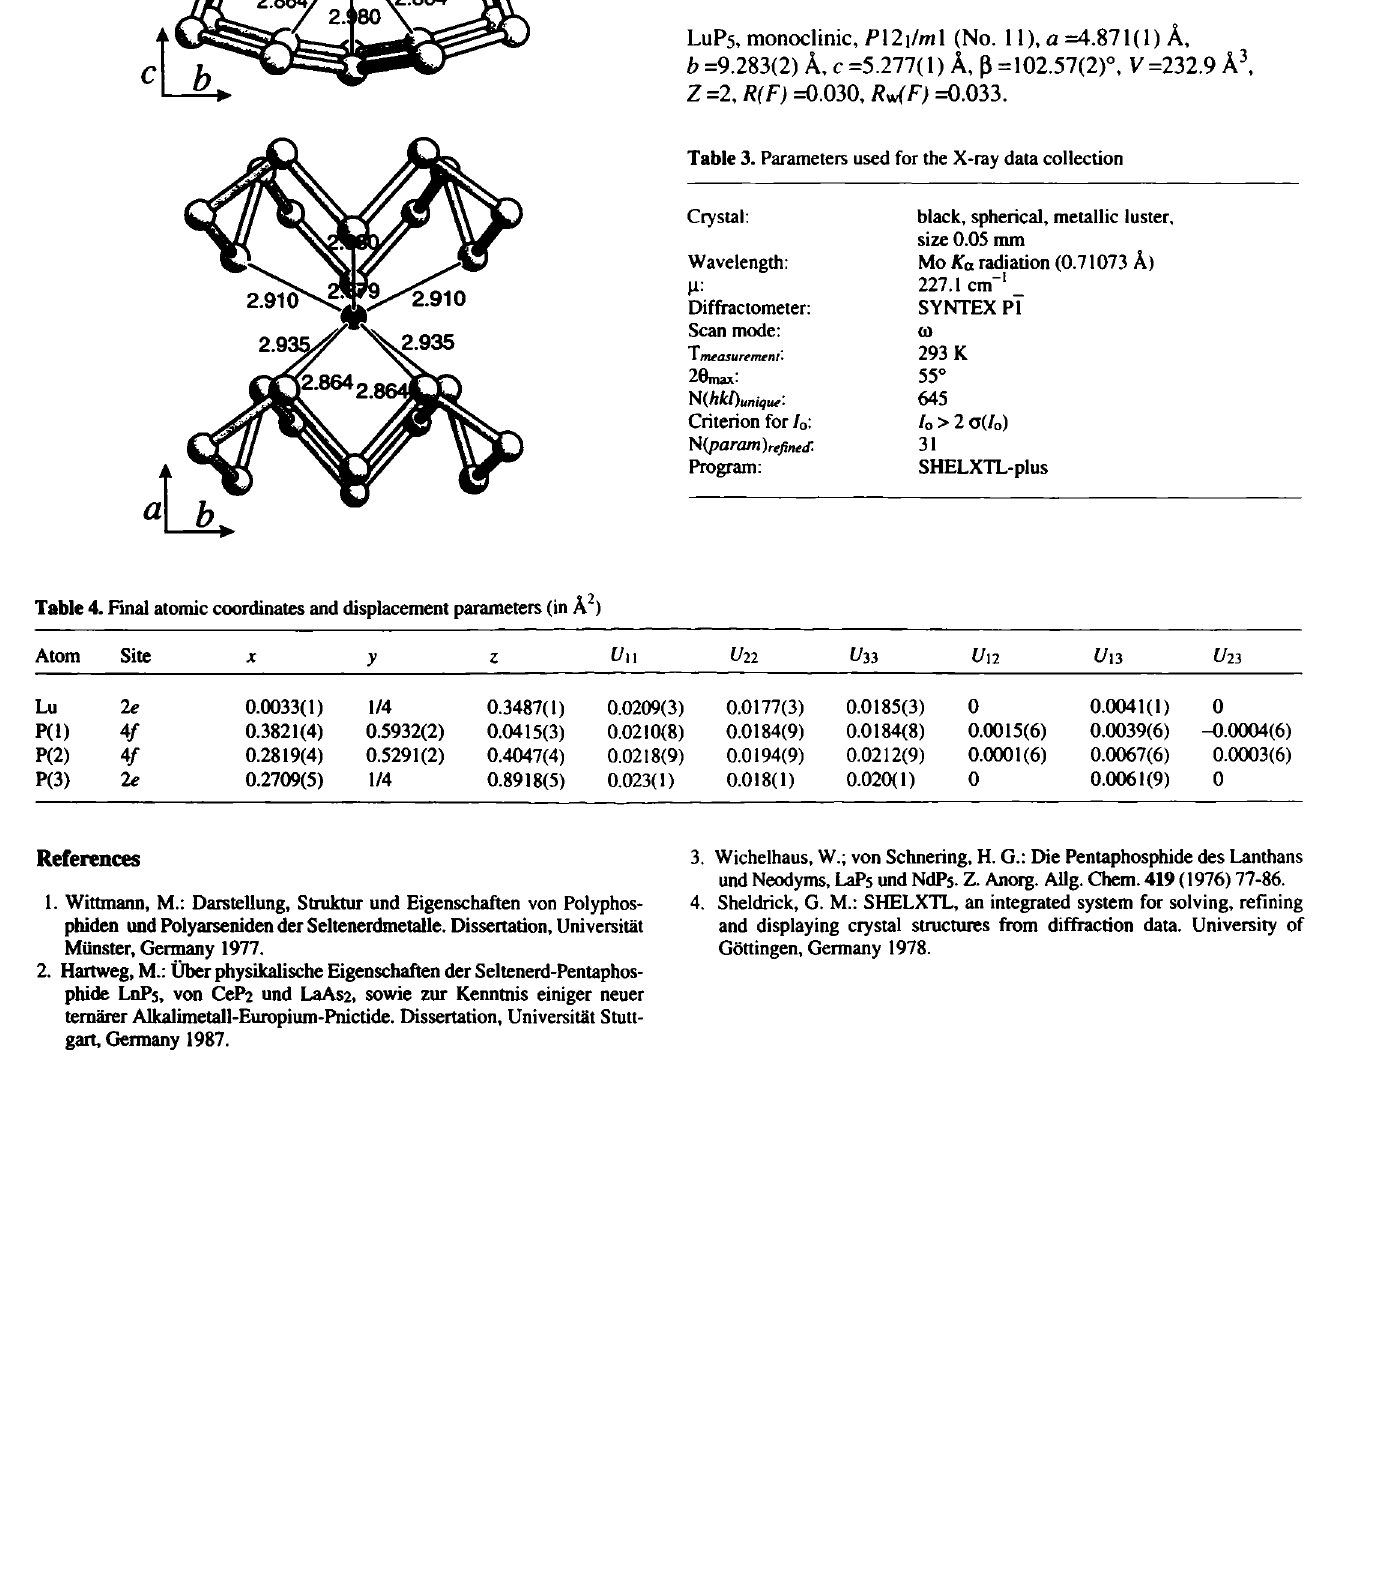
μ: 227.1 cm"' Diffractometer: SYNTEX PI Scan mode: